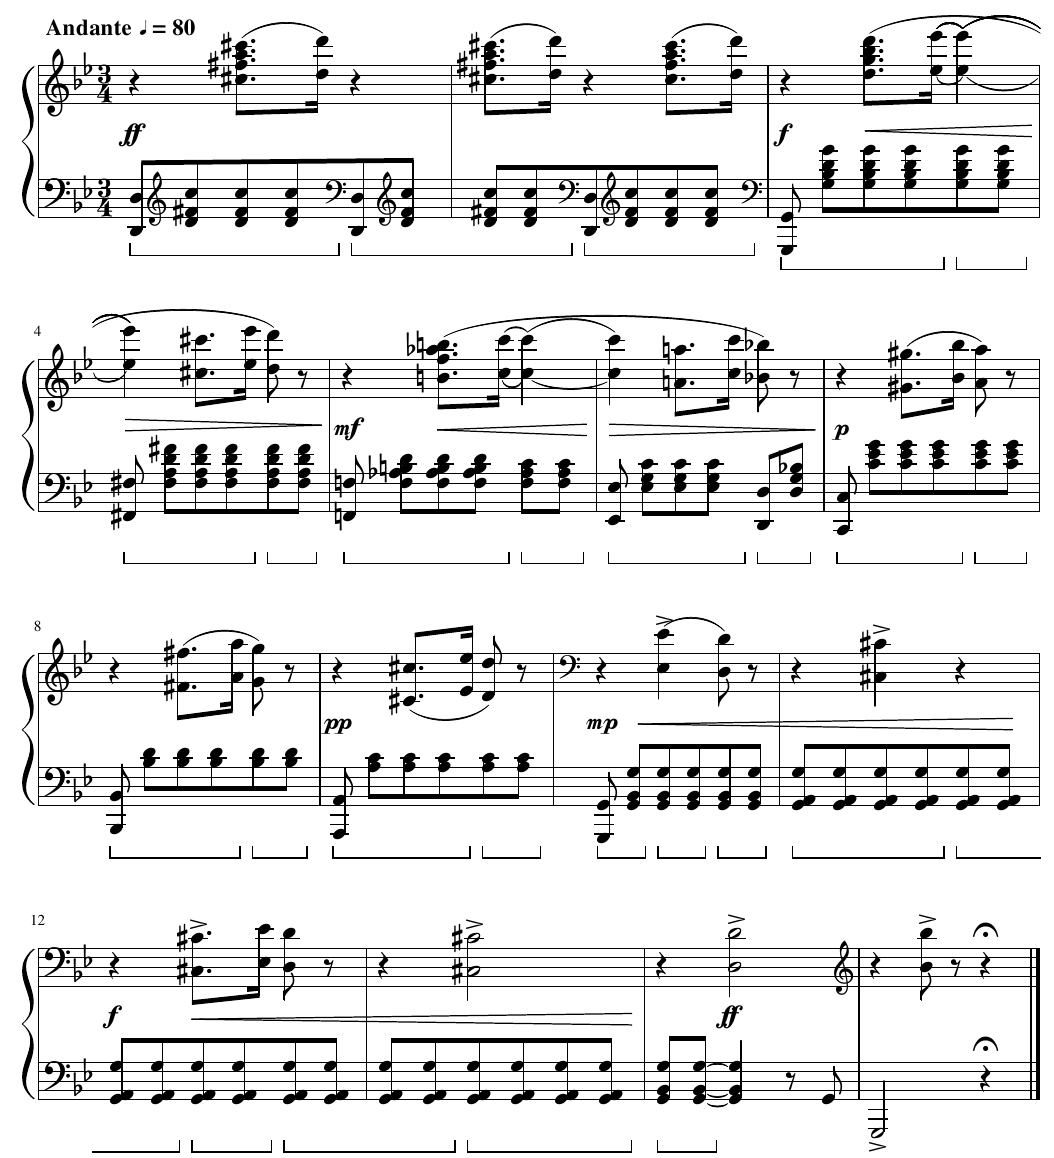
Figure A1. Music sheet of the study. The excerpt was taken from Klage by composer Gretchaninov [11]. The excerpt was edited to cover a broad dynamic range and also to include